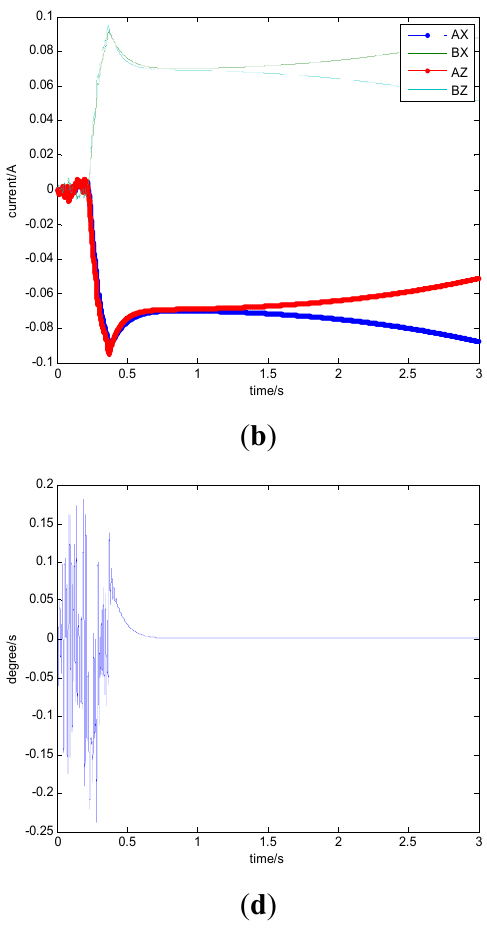
Figure 6. The curves without feedforward compensation. ( a ) Magnetic bearing torque; ( b ) Control current; ( c ) The rotor tilt angle; ( d ) The rotor tilt angle velocity; ( e ) The rotor displacement of A-side; ( f ) The rotor displacement of